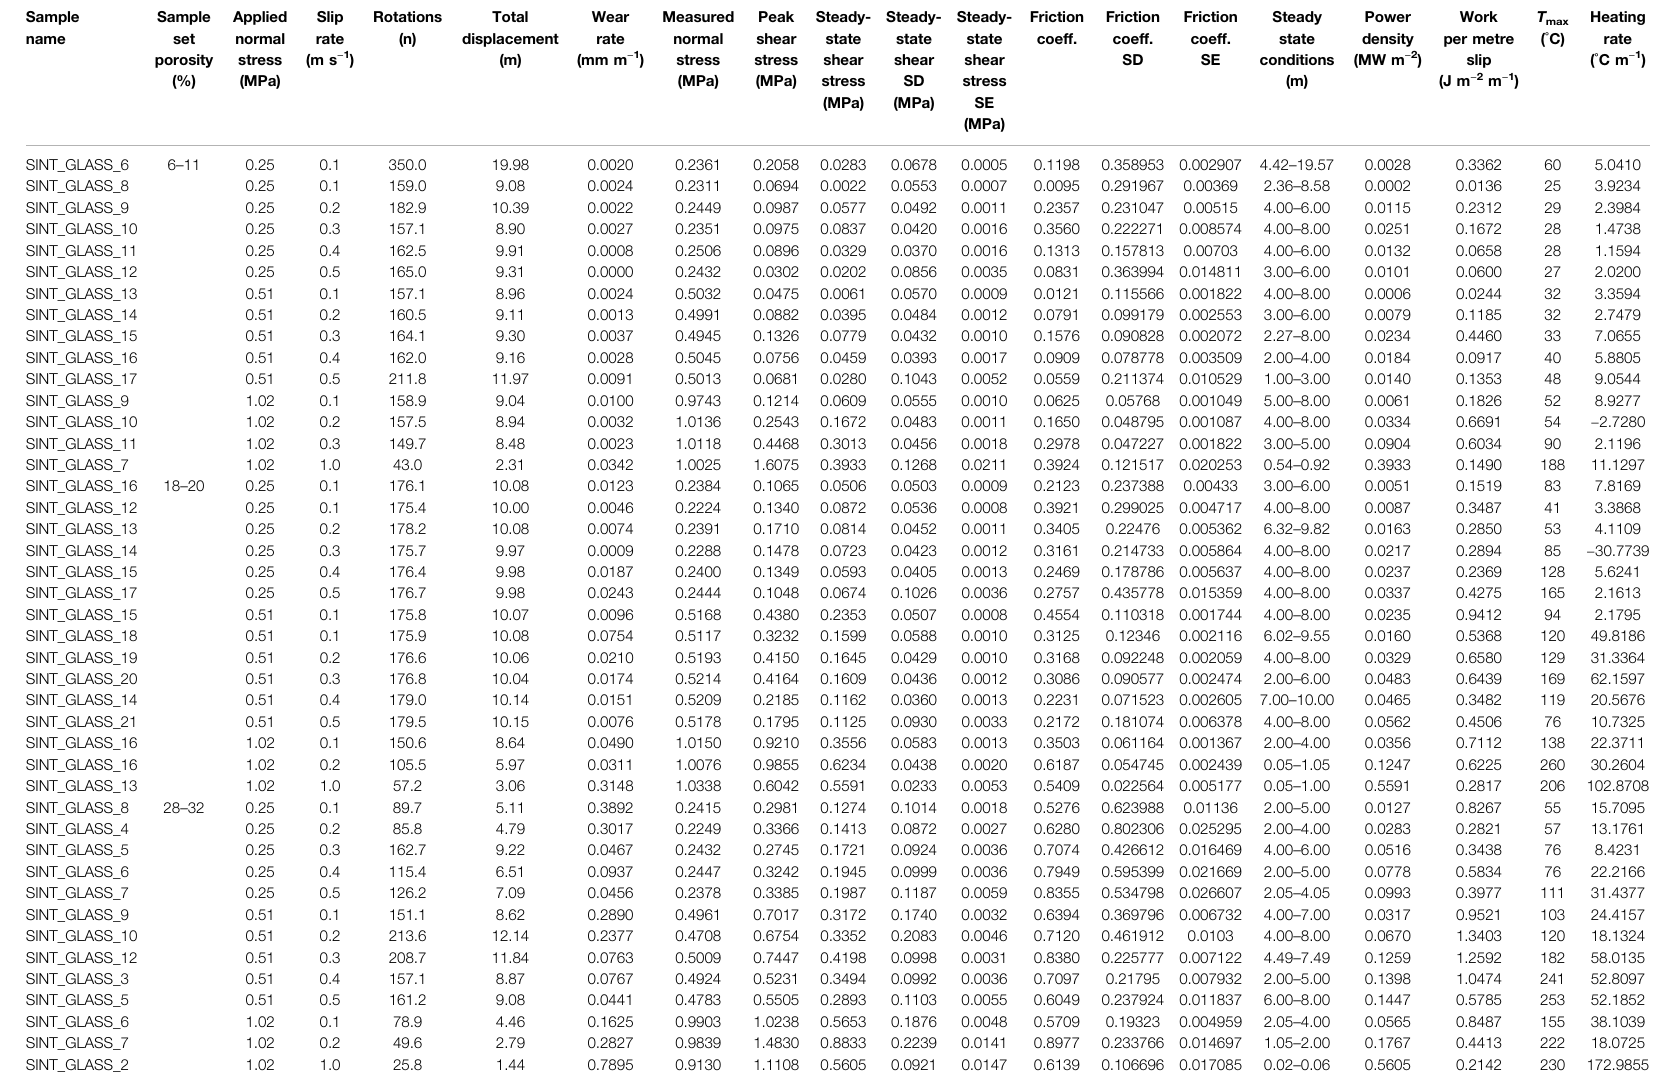
TABLE 1 | Mechanical and temperature data for all experiments. Sample